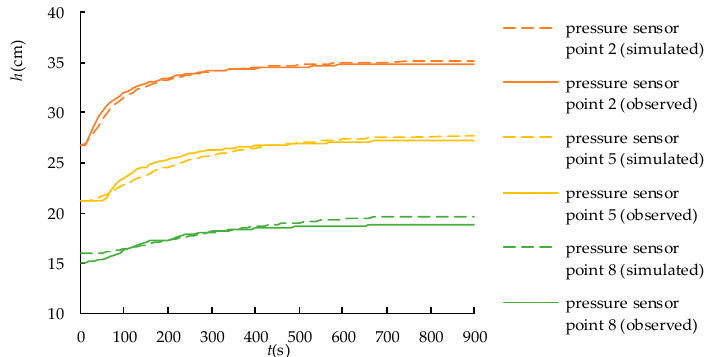
Figure 9. Comparison between observed and simulated groundwater levels at pressure sensor point 2, 5,